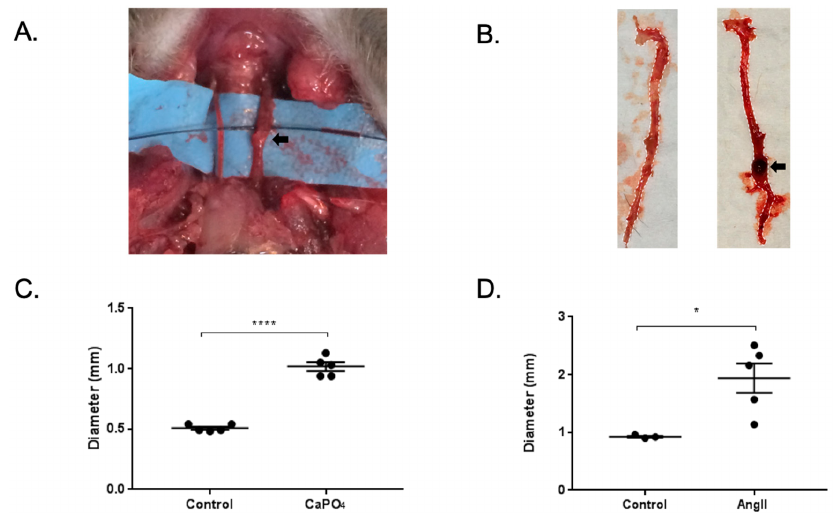
Figure 3. Mouse CaPO 4 and AngII-induced aneurysms. ( A , B ) Representative images of mice treated via perivascular application of CaPO 4 or subcutaneous administration of AngII, respectively. Black arrows indicate aneurysmal vessels. ( C , D ) CaPO 4 and AngII treatment resulted in significant vessel dilation compared to control vessels ( n = 5). In the CaPO 4 model ( C ), the contralateral carotid arteries served as controls ( n = 5), and PBS-only treated mice served as controls for the AngII model ( n = 3) ( D ). These data are expressed as mean ± SEM. * p < 0.05, **** p <